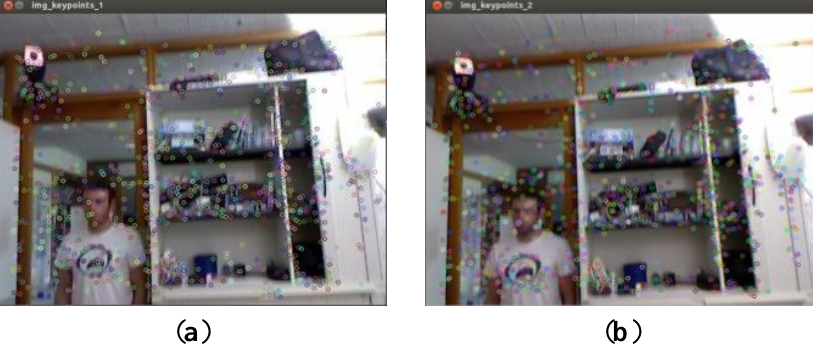
Figure 5. Results for SURF_default feature detection on frame 337th and 338th in